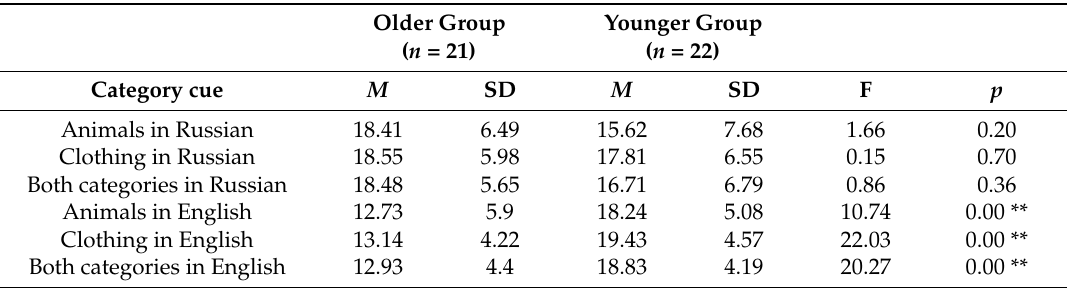
Table 5. Mean number of Russian and English words produced by participants of the older group and the younger group for each of the category fluency tasks.